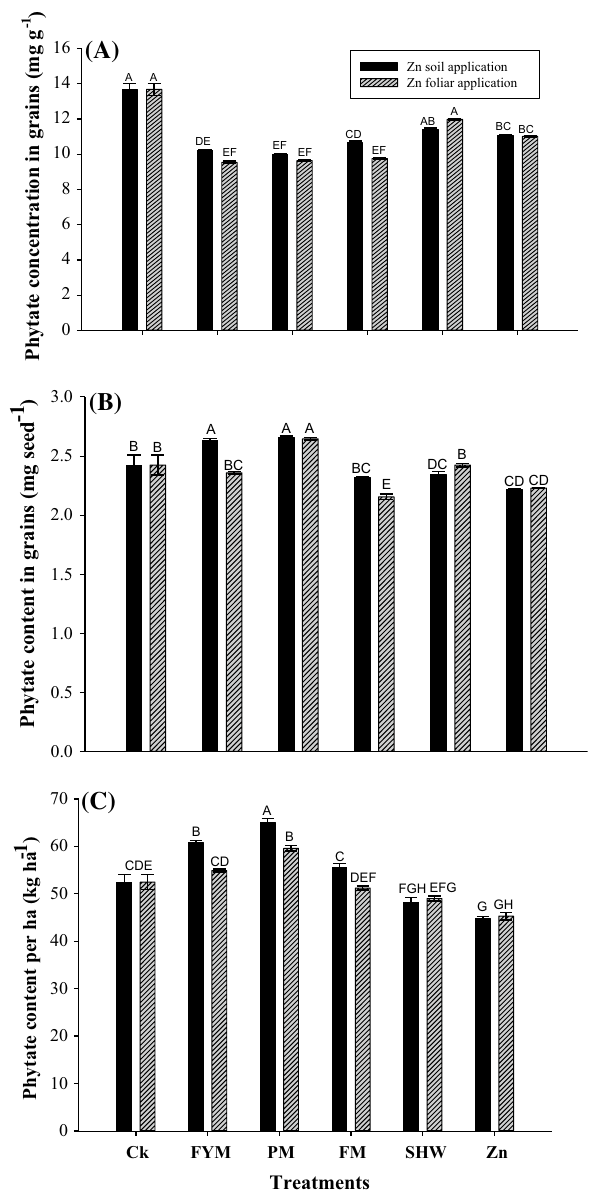
Fig. 1 Effect of organic manures and Zn fertilization on phytate con- centration ( a ), phytate content ( b ), and phytate content per ha ( c ). Different letters indicate significant differences by LSD at P ≤ 0.05 and error bars indicate ± standard error ( n = 3)